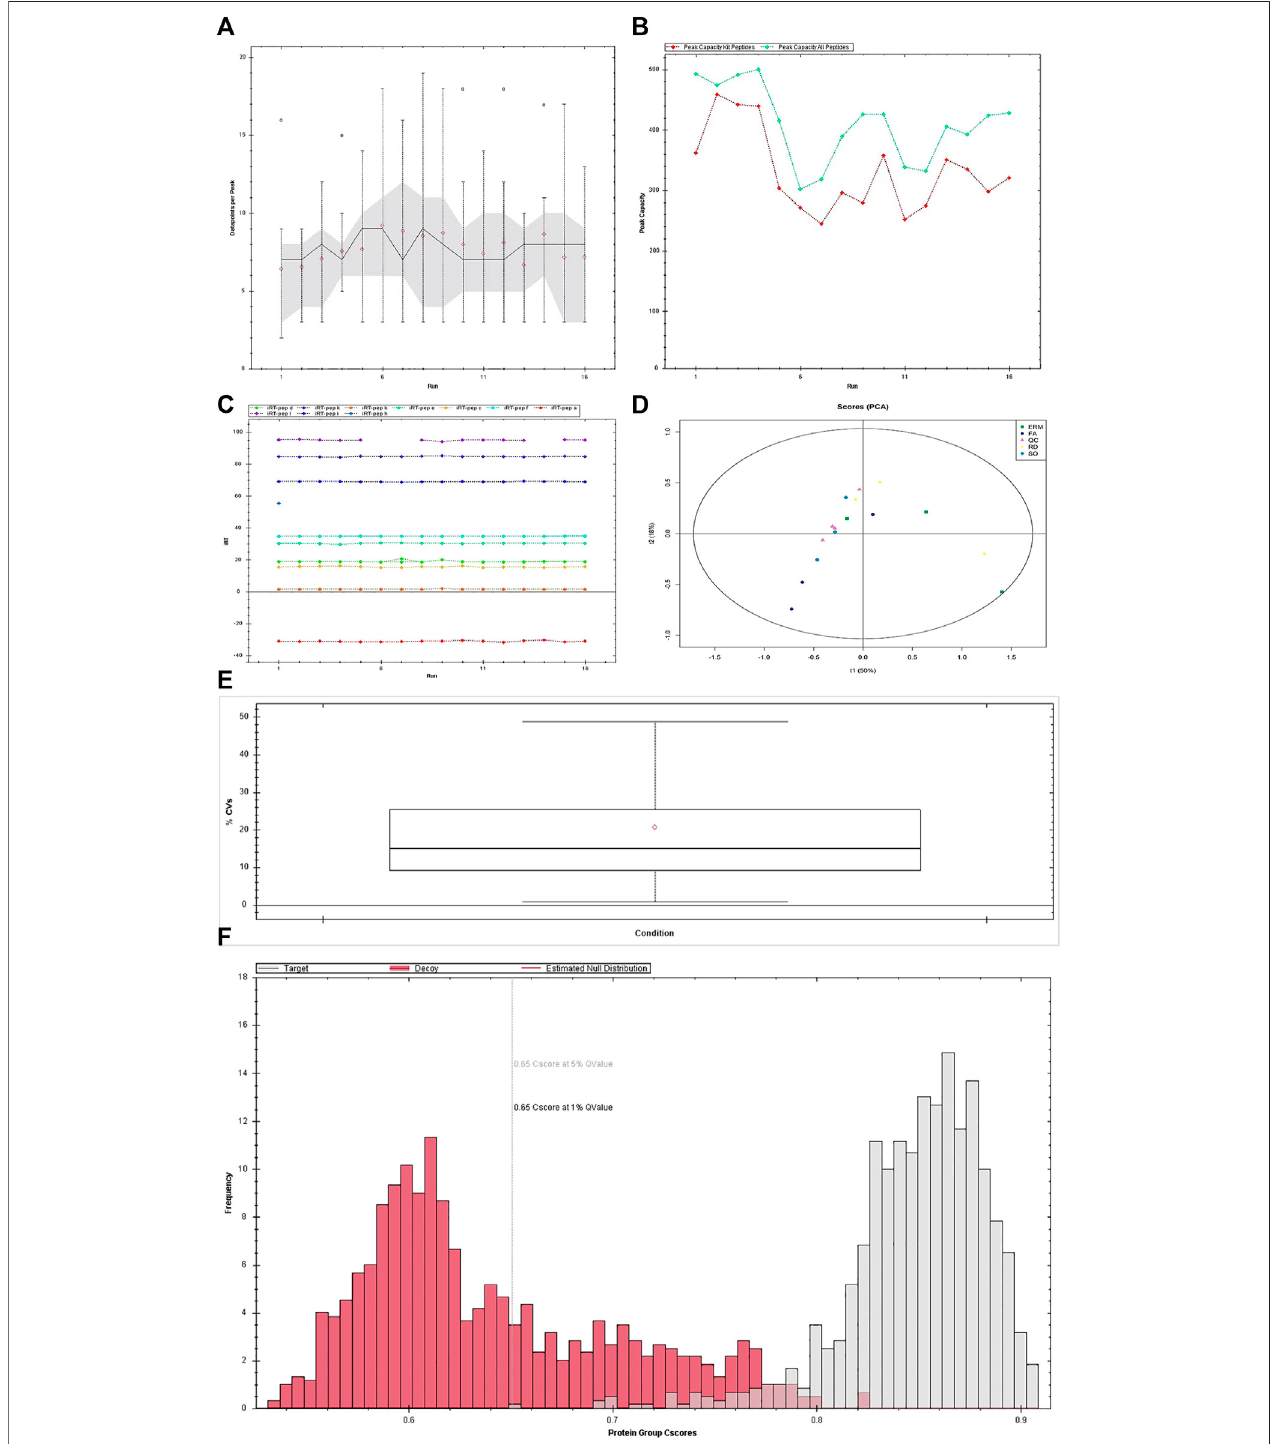
FIGURE 2 | Quality control of data-independent acquisition. (A) Average data points per peak: the average data points per peak was 8.1, which met the requirements ofthe quantitativeanalysis. (B) Column peak capacity statistics:the x-axis presentsthe orderof thesamples, thegreenline details the dataof all peptides, and thered onedetails thedata ofthe iRTinternal standard. Peak capacity represented the separation and analysiscapabilityofthe column. The averagepeak capacity was 409.8, indicating better separation and analysis. (C) Elution time of iRT peptide segment: the main iRTs were detected, and the retention time was generally stable. (D) Chart of principal component analysis (PCA). Detected changes in the protein shown in PCA plots could well explain the differences in this experiment. (E) Proteinfalsediscoveryrate(FDR)distributiondata.ThequalitativeresultsarehighlyreliableundertheFDR0.01standard. (F) CVdistribution ofQCsamples.Themedian CV of the QC sample was 15.1%, indicating the high stability of the experimental